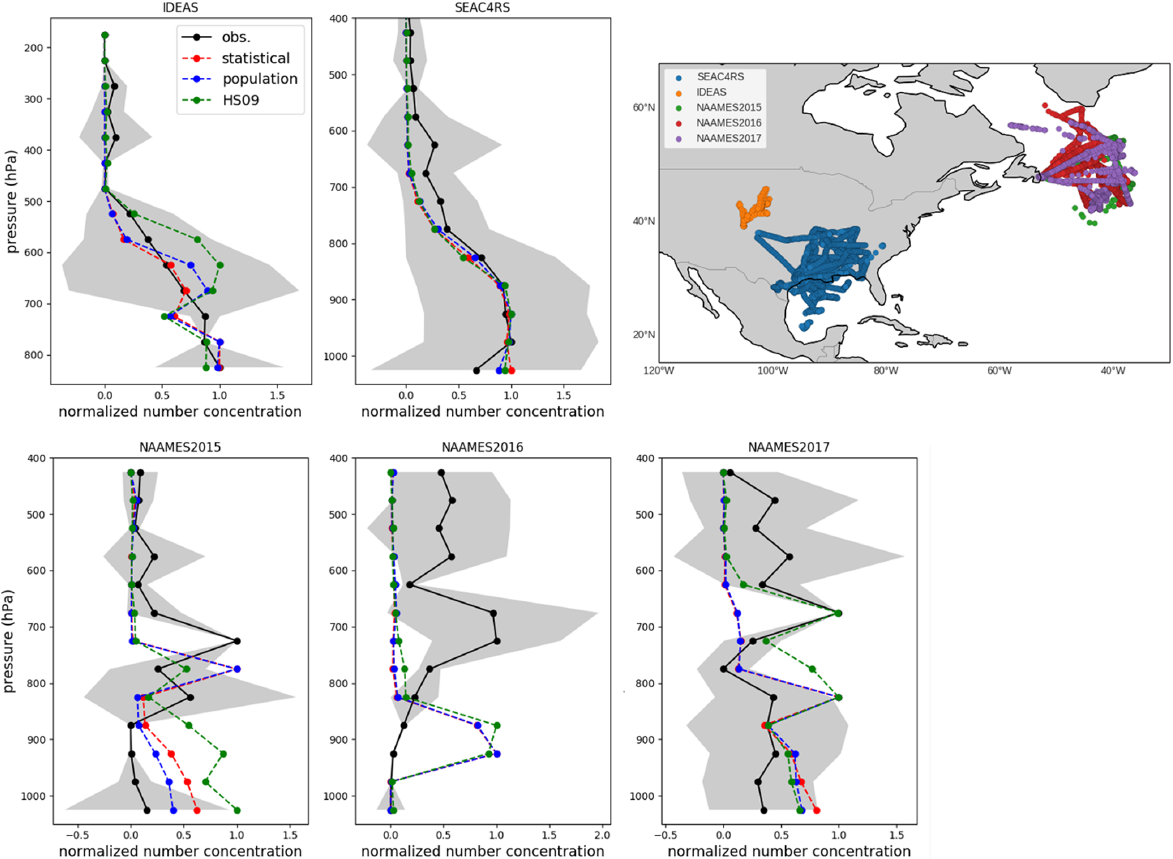
Figure 10. Normalized vertical profiles of fluorescent biological aerosol particles (FBAPs) from five campaigns (black) compared with normalized vertical profiles of fungal spore number concentrations from three model simulations: the population model (blue), the statistical model (red) and the HS09 model (green). Normalized profiles are obtained by applying min–max normalization, which scales all values to a range between 0 and 1. Standard deviation of observations in each 50hPa pressure bin are shown in grey. The upper-right panel shows the flight tracks for each